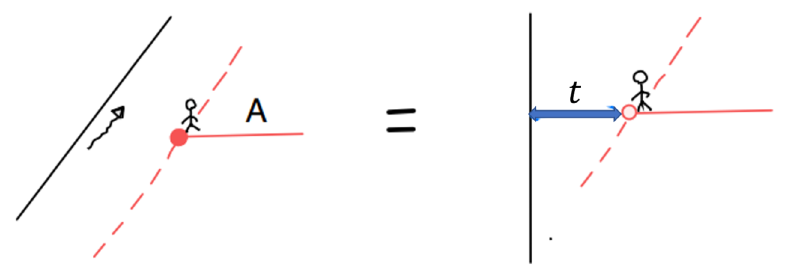
( t ) − u ( t ) of the 0 0